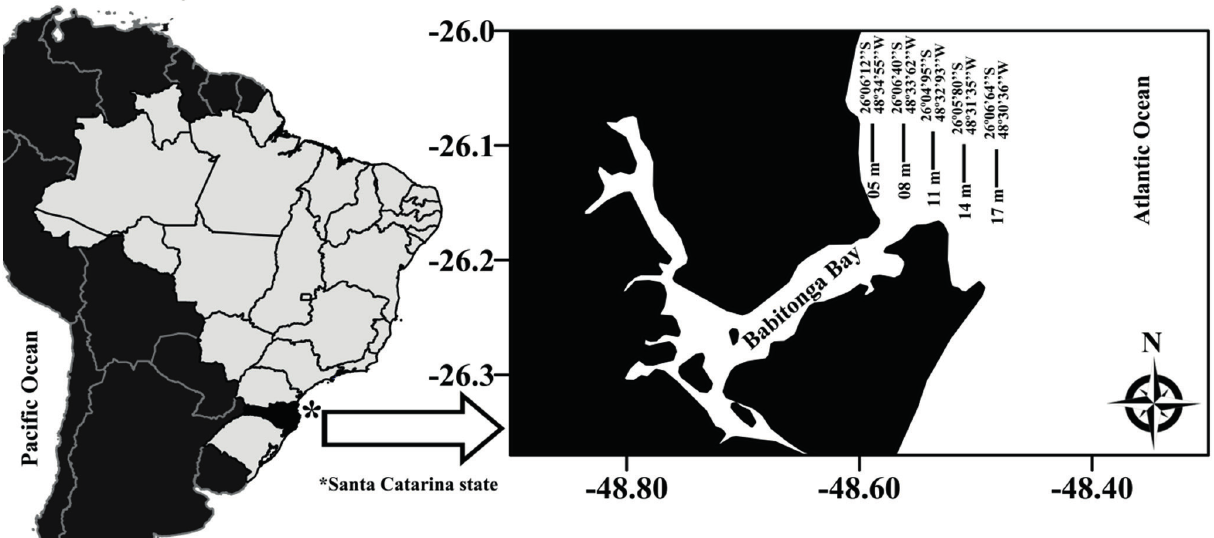
Figure 1. Location of the study area, highlighting the sampled stations in an area adjacent to Babitonga Bay, Santa Catarina, Brazil (source: Grabowski et al.,